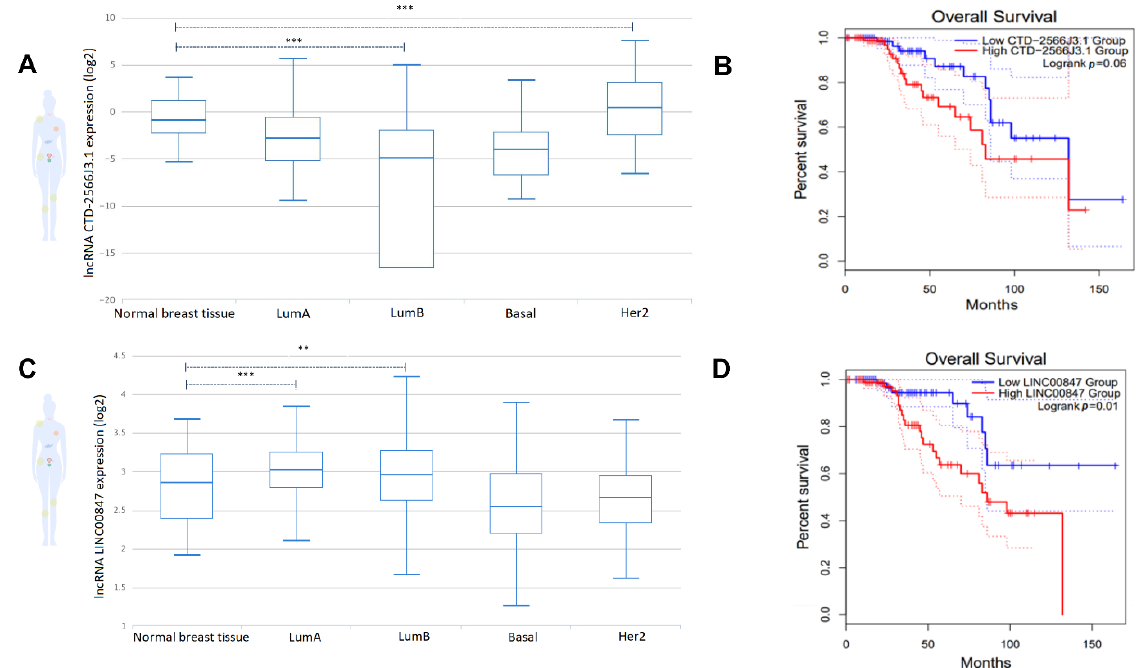
Figure 8. Expression of lncRNAs by molecular subtypes and impact on overall survival rates. ( A ) CTD-2566J3.1 gene expression in breast cancer molecular subtypes. ( B ) Kaplan-Meier survival curves for CTD-2566J3.1 associated with overall survival in luminal B breast cancer. The x-axis represents overall survival time (months) and the y-axis represents survival function. ( C ) LINC00847 gene expression in breast cancer molecular subtypes ( D ) Kaplan-Meier survival curves for LINC00847 associated with overall survival in luminal B breast cancer. The x-axis represents overall survival time (months) and the y-axis represents survival function. Student’s t -test (** p < 0.01, *** p < 0.001).